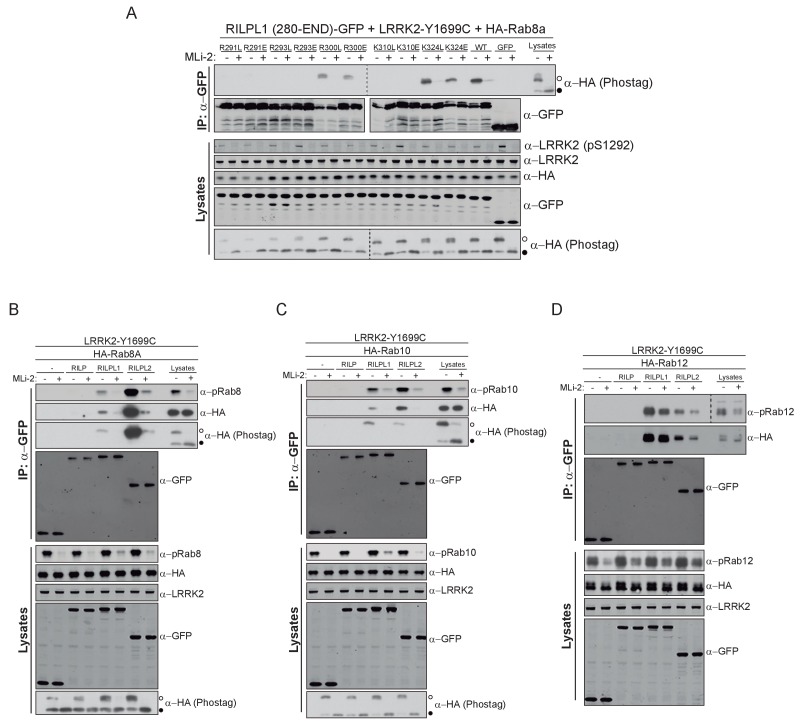
Phospho-dependent interaction of Rab8A, Rab10 and Rab12 with RILPL1/2.(A) GFP pulldown of different mutants of the C-terminal domain of RILPL1 (280-END) transiently expressed with HA-Rab8A and LRRK2-Y1699C in HEK293 cells (wt = wild type). Western blot and Phos-tag were used to detect interacting proteins using the indicated antibodies. (MLi-2 = 150 nM, 2 hr). (B), (C) and (D) Same as (A) but using full-length GFP-tagged RILP, RILPL1 or RILP2, co-expressed with either Rab8A, Rab10 or Rab12 and LRRK2-Y199C. For phos-tag blots filled circles indicate non-phosphorylated proteins and open circles phosphorylated proteins.